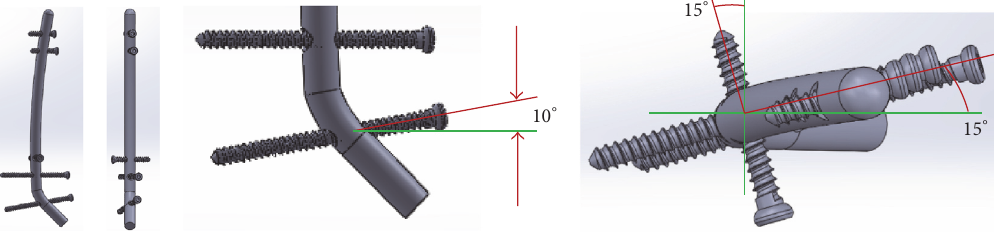
Figure 9: Final nail